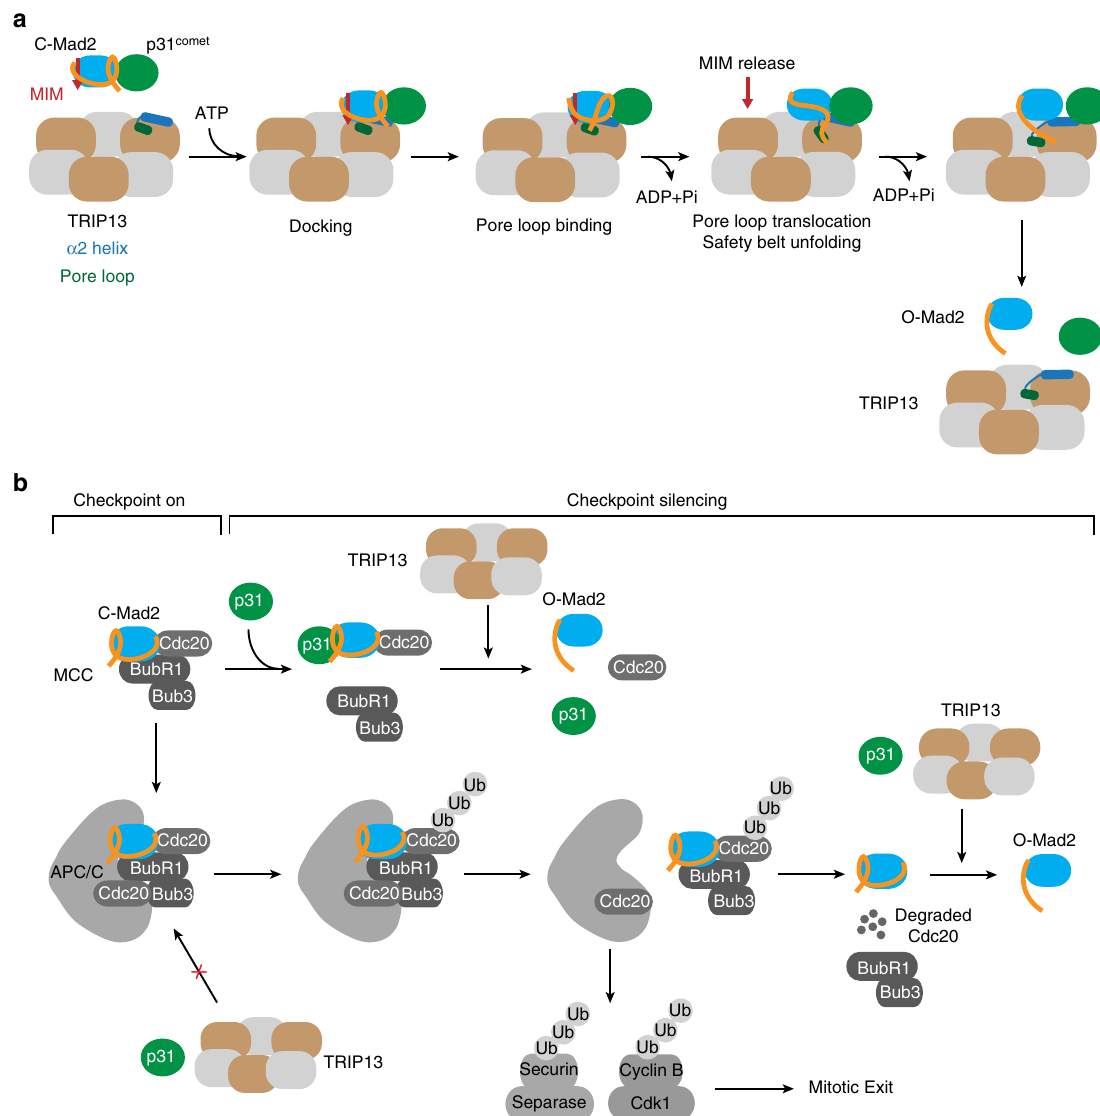
Fig. 8 Mechanisms of TRIP13-dependent Mad2 conformational change and checkpoint silencing. a Model of TRIP13-catalyzed conversion of C-Mad2 to O-Mad2. The p31 comet – C-Mad2 – MIM complex docks on the α 2 helix of TRIP13. The pore loop of TRIP13 engages the C-terminus of Mad2. ATP hydrolysis drives the translocation of the pore loop and the associated Mad2 C-terminus, leading to the local unfolding of the C-terminal safety belt of C-Mad2. This Mad2 local unfolding releases MIM and disrupts the p31 comet – Mad2 interaction. Mad2 refolding produces O-Mad2. Both p31 comet and O-Mad2 dissociate from TRIP13. b Model of TRIP13-dependent checkpoint silencing. Upon spindle checkpoint activation, MCC is produced at unattached kinetochores and diffuses into the cytosol to inhibit APC/C Cdc20 . During checkpoint silencing, the production of MCC is attenuated. p31 comet binds to C-Mad2 in MCC